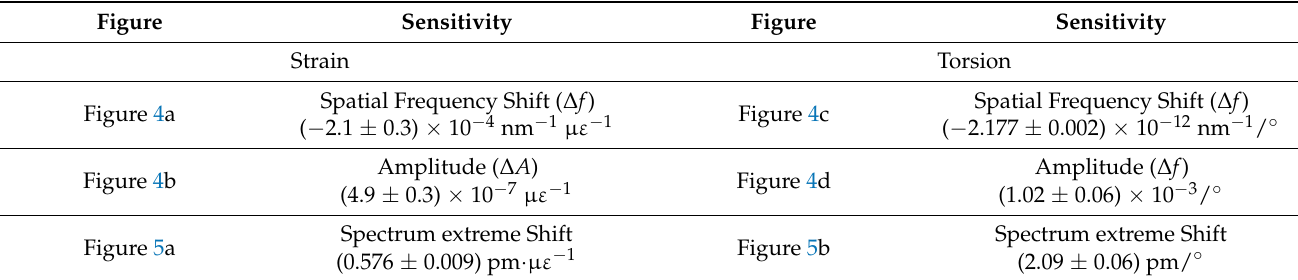
Table 1. Linear sensibility of Figures 4 and 5.